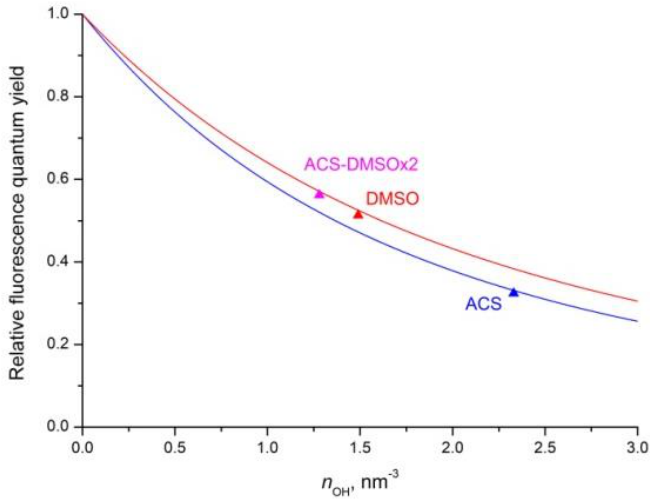
Figure 9. Calculated dependences of the relative fluorescence quantum yield ϕ of colloidal solutions of the 0.1 at. % Nd 3+ : LaF 3 NPs on the concentration of OH- groups in the bulk of NPs: ACS colloid — blue curve, and DMSO colloid — red curve ; triangles are the experimentally measured values of the fluorescence quantum yield (see Table 1).